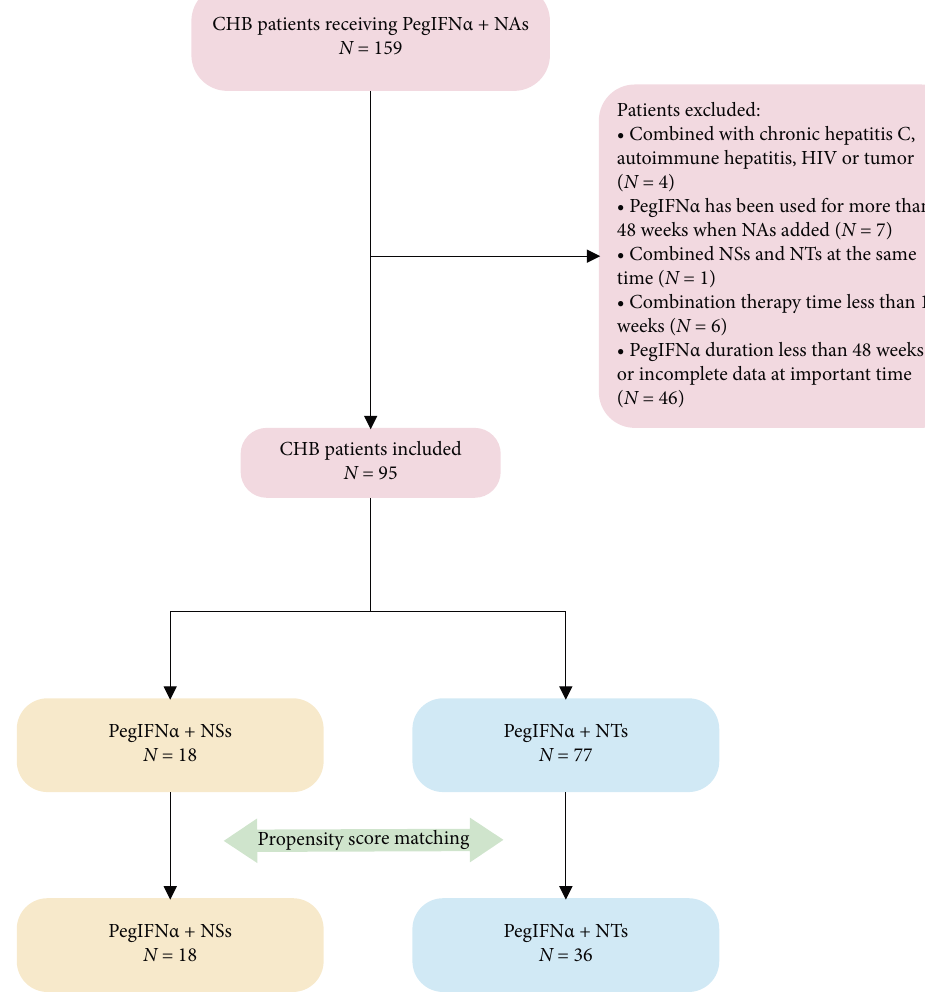
Figure 1: Flow diagram describing the selection of the study